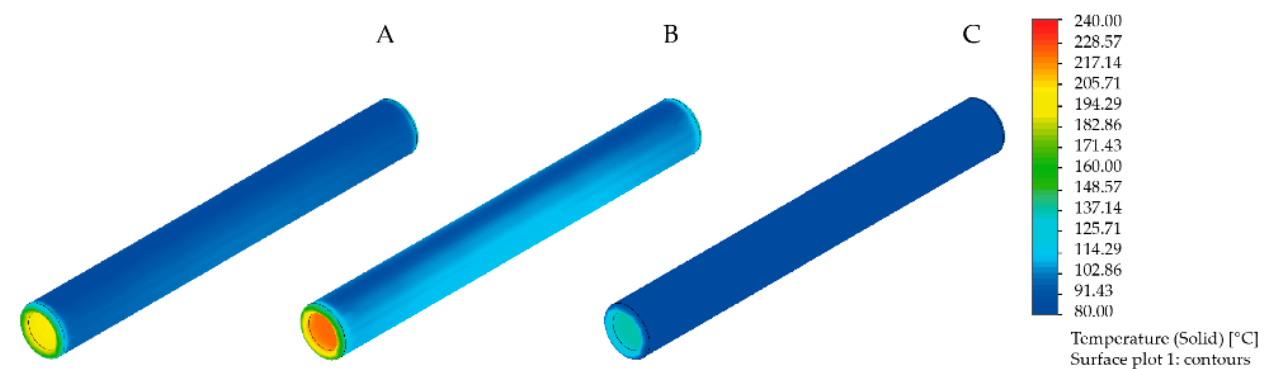
Figure 9. Isometric view of the surface temperature of the vacuum glass tube for the North Africa ( A ), South China ( B ) and Indonesia ( C ).